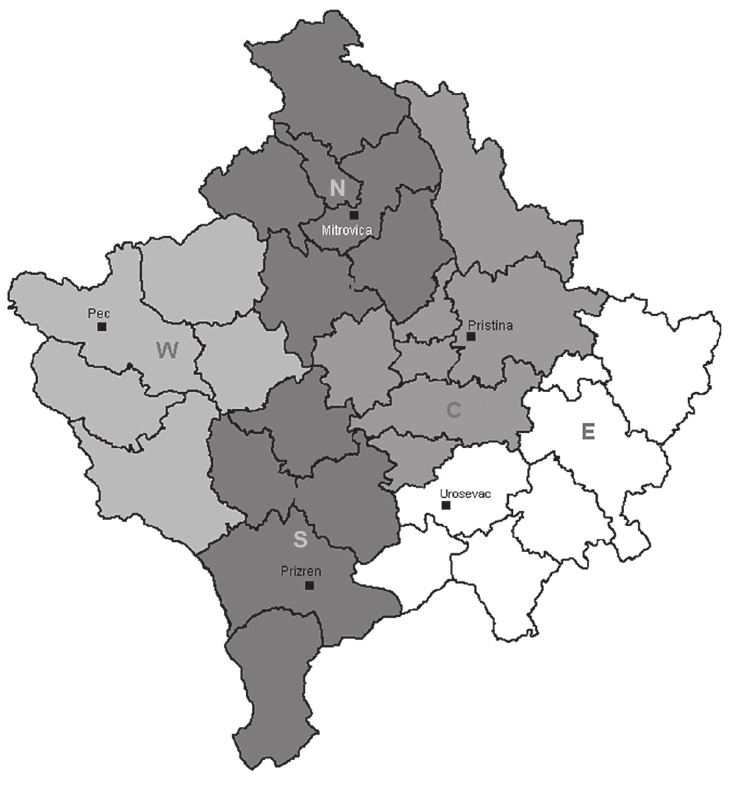
FIGURE 1 Administrative regions of Kosovo (Source: KFOR_Structur.2006,